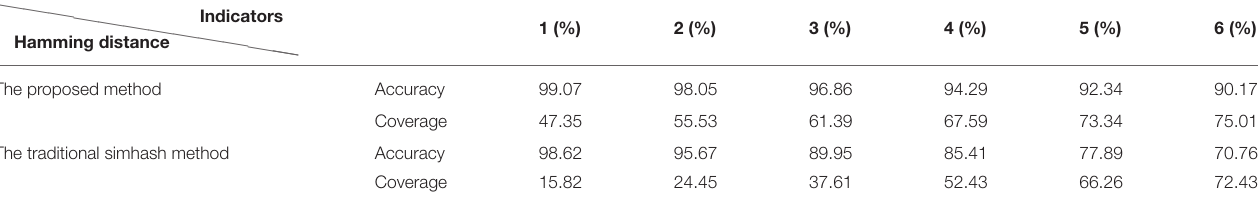
TABLE 1 | Comparison of data classifying